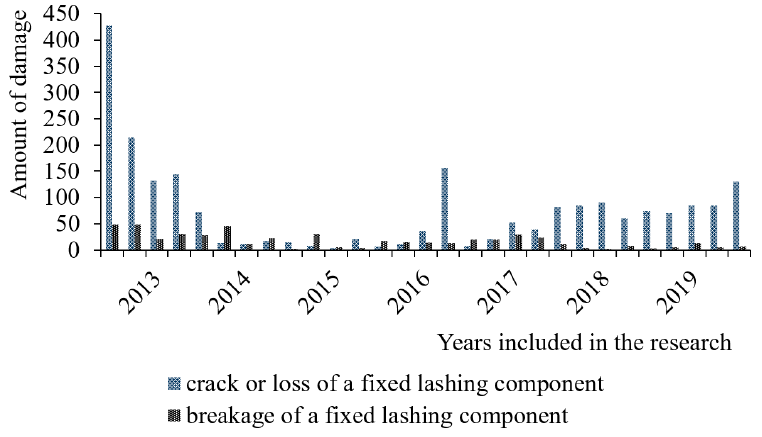
Figure 1. Amount of damage in fixed lashing components of the flat cars in operation.